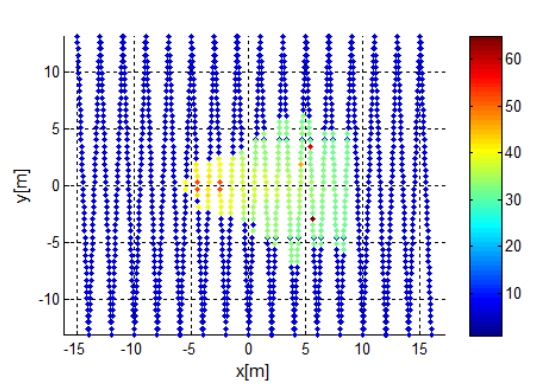
Figure 20. Final product of